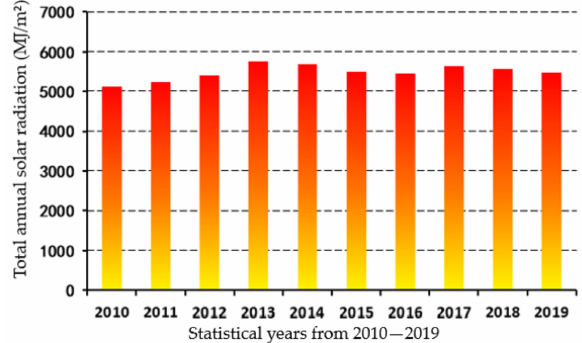
Figure 1. Annual solar radiation at the Akesu meteorological station